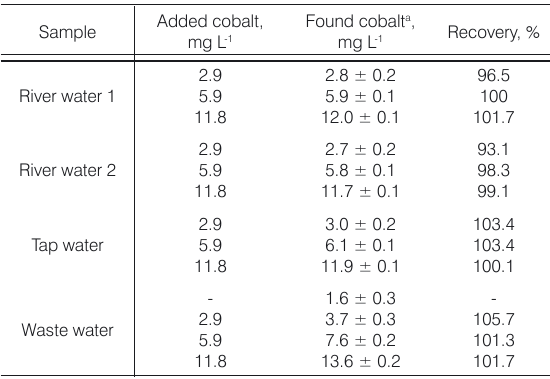
Table 3. Determination of Co 2+ by the proposed electrode in real samples. Added cobalt, Sample mg L -1